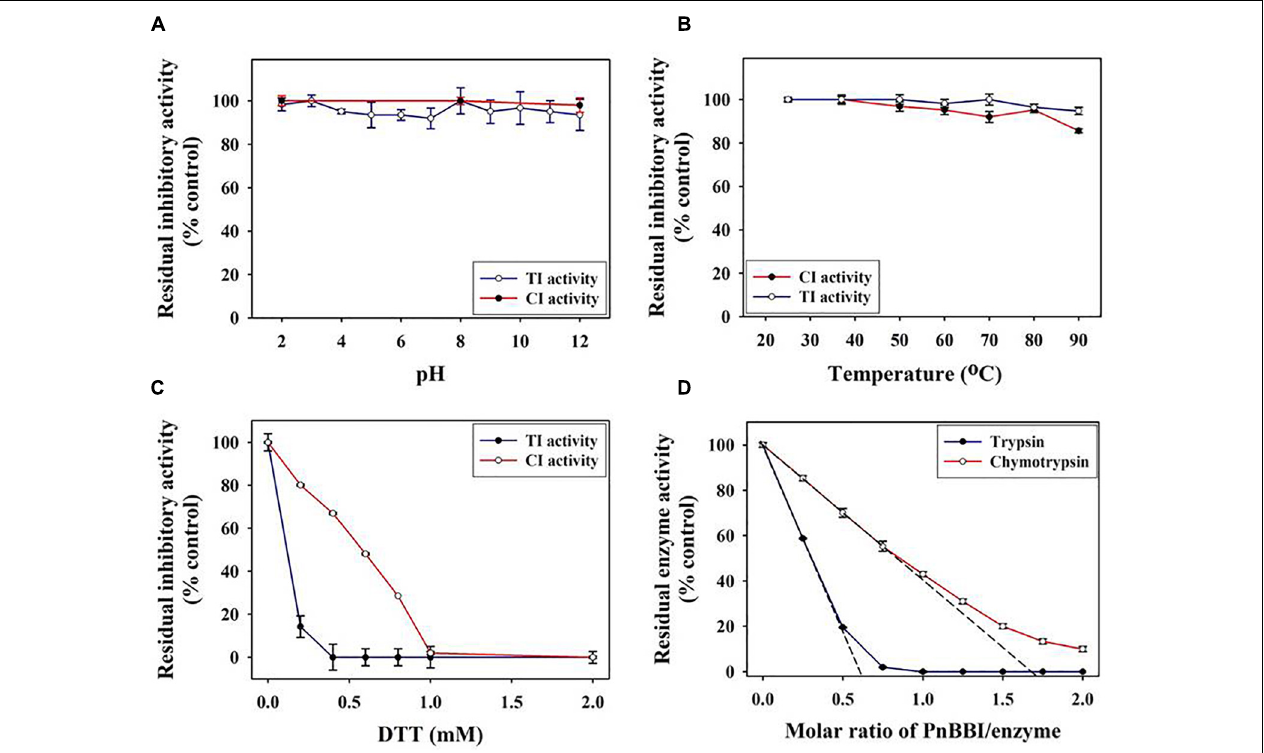
FIGURE 5 | Functional stability of PnBBI. The TI and CI activities of PnBBI were monitored at a broad range of (A) pH; (B) temperature and (C) reducing agent Dithiothreitol (DTT). The amount of PnBBI equivalent to one TI or CI units was incubated at different pH, temperatures or DTT concentration and residual inhibitory activities against trypsin and chymotrypsin was monitored using respective substrates as described in methods (Section “Inhibitory Activity of PnCPI and PnBBI”); (D) Titration curve of trypsin and chymotrypsin inhibition by PnBBI. A fixed amount of enzyme (1 µ M trypsin and/or 2 µ M chymotrypsin) was mixed with different concentrations of PnBBI and the residual protease activity was determined. The x-intercept where the corresponding proteases are completely inhibited by the inhibitor was the molar binding ratio. The data represented is mean ± SE of three biological